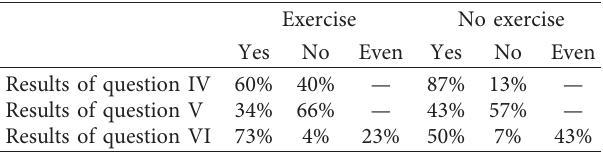
Figure 4: Results for question IV (“exercise” and “no exercise” indicate that the subject answered “yes” and “no” in questionnaire III, respectively). Table 4: Results for questions IV, V, and VI with respect to exercise